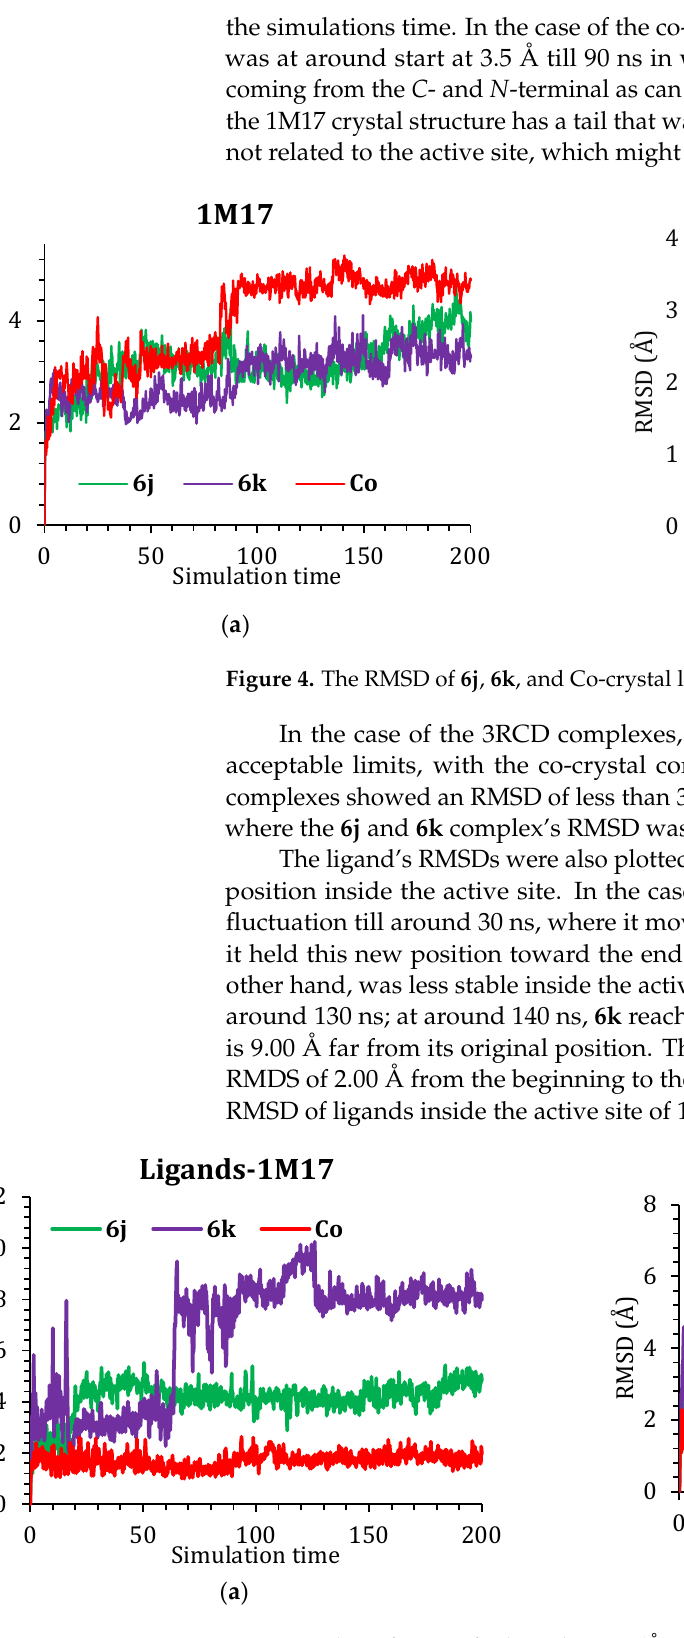
Figure 5. Plots of RMSD for ligand atoms (Å ) with respect to the initial structure vs. simulation time (ns) for all the complexes.